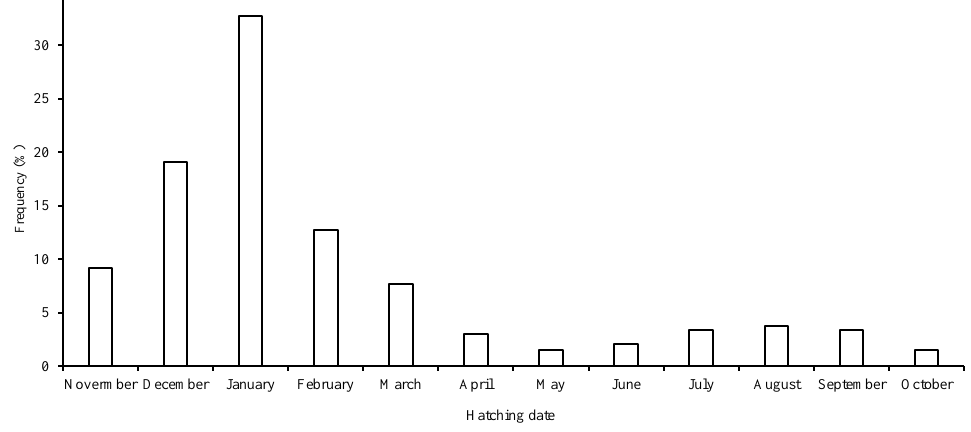
Figure 5. Frequency distribution of age structure for S. oualaniensis in the waters of the Xisha Islands of the South China Sea.